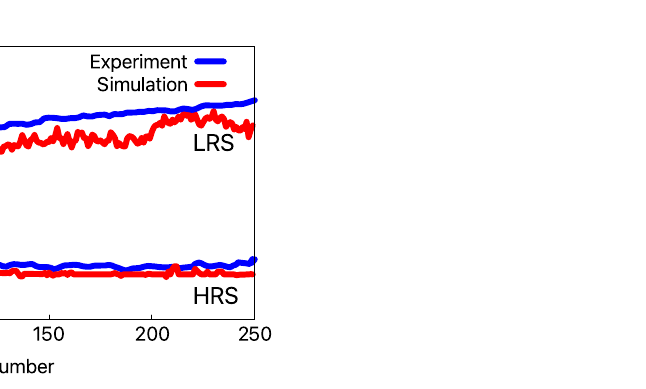
Figure 8. The comparison between simulated and experimental retention characteristics of a BFO memristor. The current evolution is recorded every 10 s for 3000 cycles for both LRS and